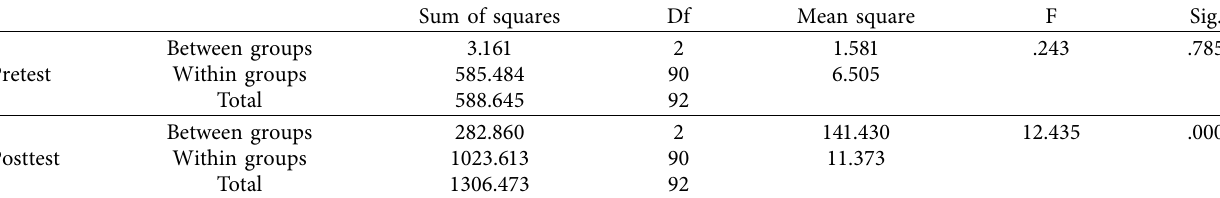
Table 2: Inferential statistics of all groups on the pre- and